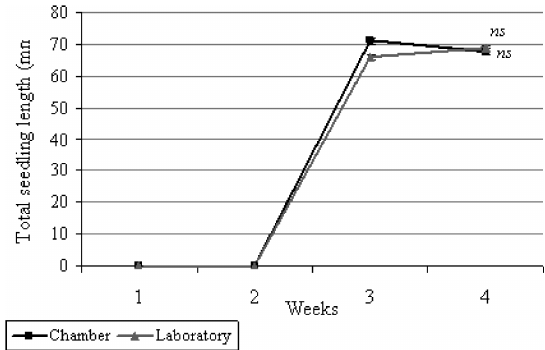
Figure 3. The growth and total length (mm) of new seedlings in the two